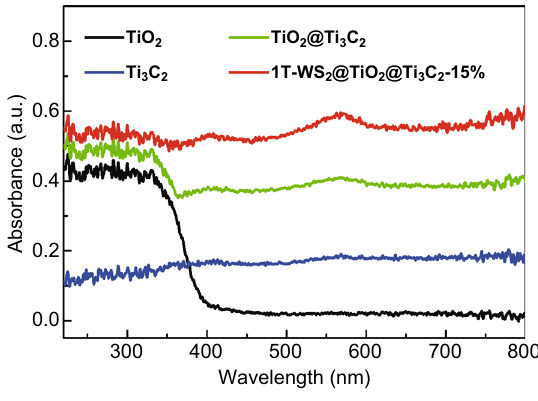
Fig. 5 UV–Vis DRS spectra of Ti 3 C 2 MXene, TiO 2 NSs, TiO 2 @ Ti